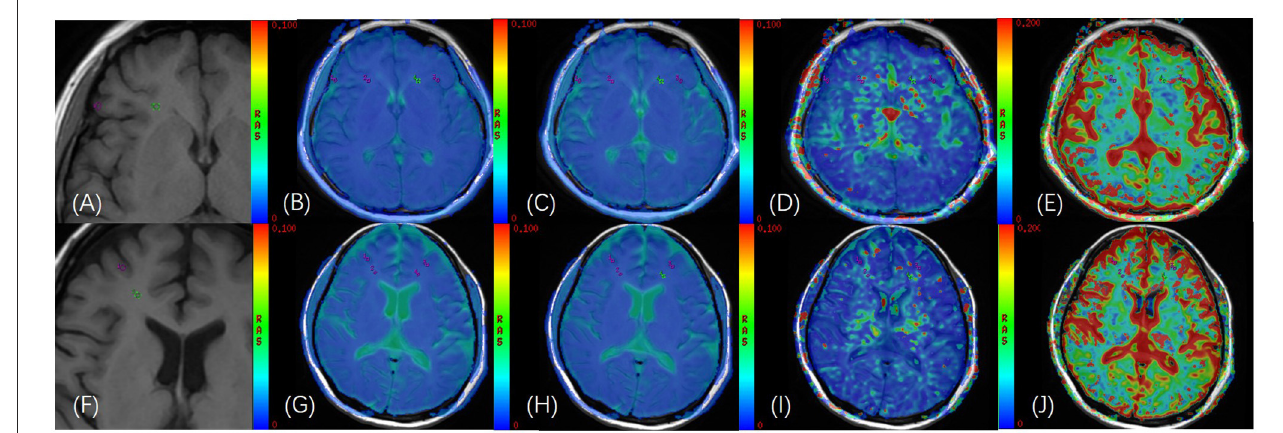
FIGURE2 (A) T 1 WI images of a 40-year-old female healthy participant; (B–E) GM and WM of bilateral frontal lobes were delineated on the fusion image of axial IVIM functional image [apparent diffusion coecient (sADC), D , D * , and f , respectively] and axial T 1 WI image, and the ROI area was 11mm 2 ; (F) T 1 WI images of a 50-year-old female patient with AL; (G–J) GM and WM of bilateral frontal lobes were delineated on the fusion image of axial IVIM functional image [apparent diffusion coecient (sADC), D , D * , and f , respectively] and axial T 1 WI image, and the ROI area was 11mm 2 .